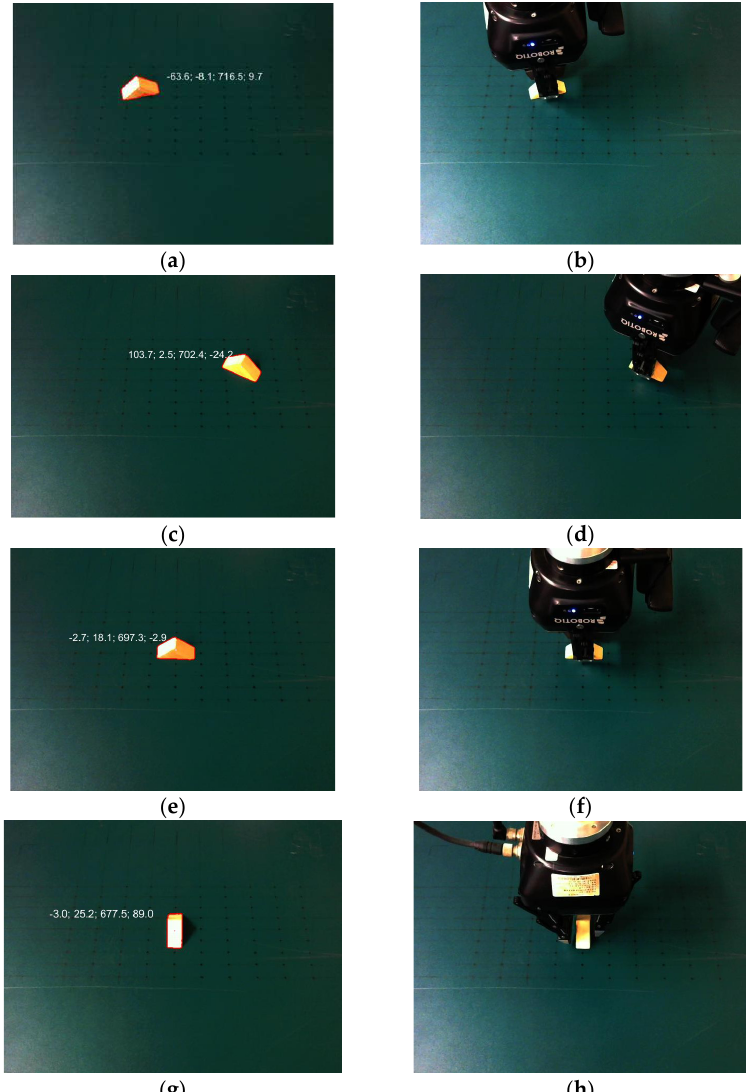
Figure 15. Estimations of the object and the gripper ( a ) The measured orientation of the object is 85.85 ◦ , ( b ) The orientation of the gripper is 83.71 ◦ , ( c ) The measured orientation of the object is 117 ◦ , ( d ) The orientation of the gripper is 119.95 ◦ , ( e ) The measured orientation of the object is 93.78 ◦ , ( f ) The orientation of the gripper is 93 ◦ , ( g ) The measured orientation of the object is 6.23 ◦ , ( h ) The orientation of the gripper is 6 ◦